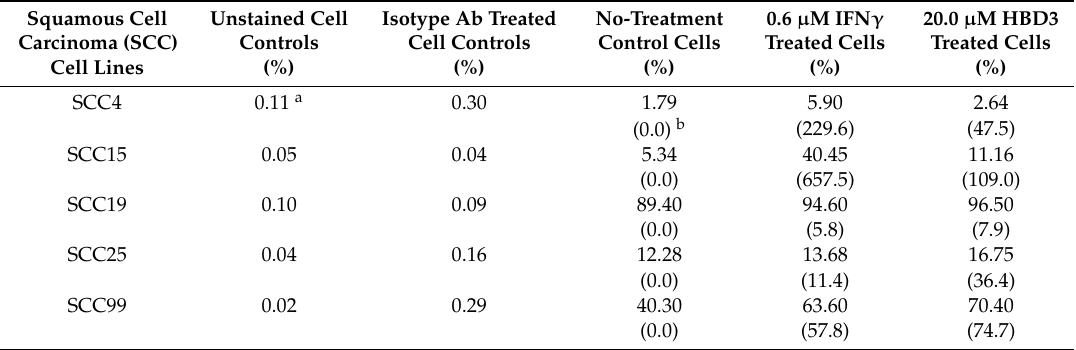
Table 3. Flow cytometry analysis showing the percent of SCC4, SCC15, SCC19, SCC25, and SCC99 cells with PD-L1 expression after treatments with 20.0 µ M human β -defensin 3 (HBD3) (test) or 0.6 µ M IFN γ (control). The percent increase in staining of cells with PD-L1 expression treated with 0.6 µ M IFN γ or 20.0 µ M HBD3 over the no-treatment control cells is